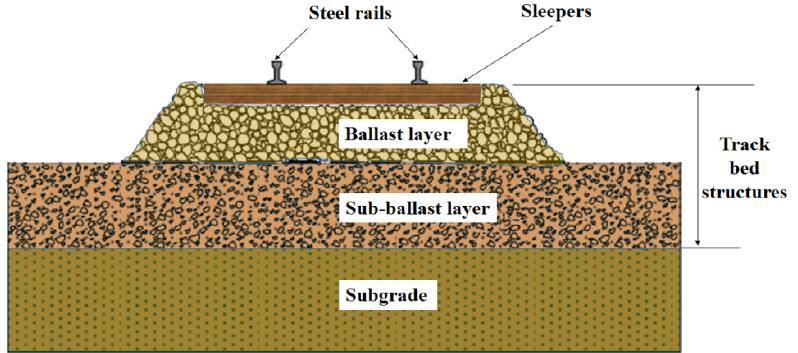
Figure 1. Ballast track structure.